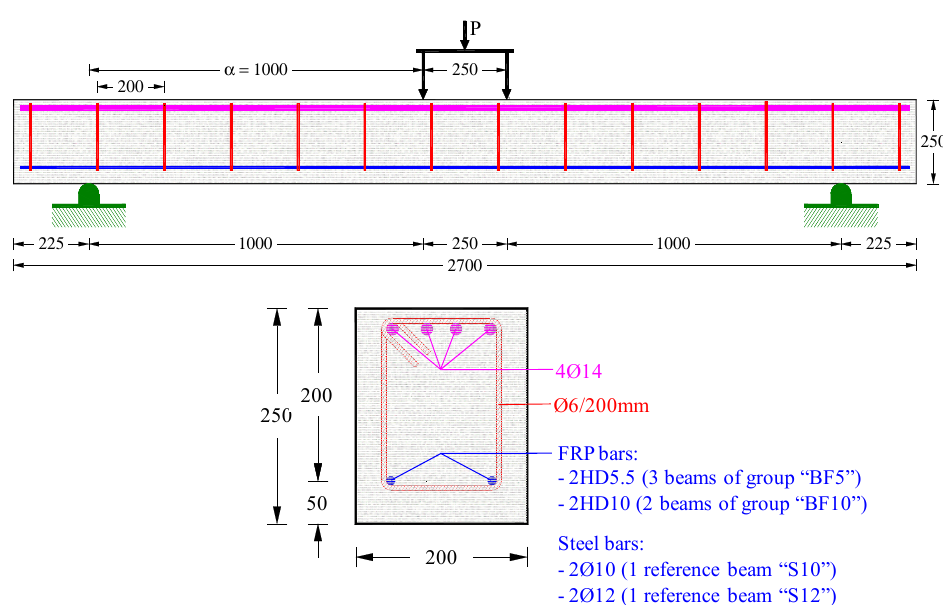
Figure 1. Geometry, reinforcement, and cross-section details of beam specimens (dimensions in mm).